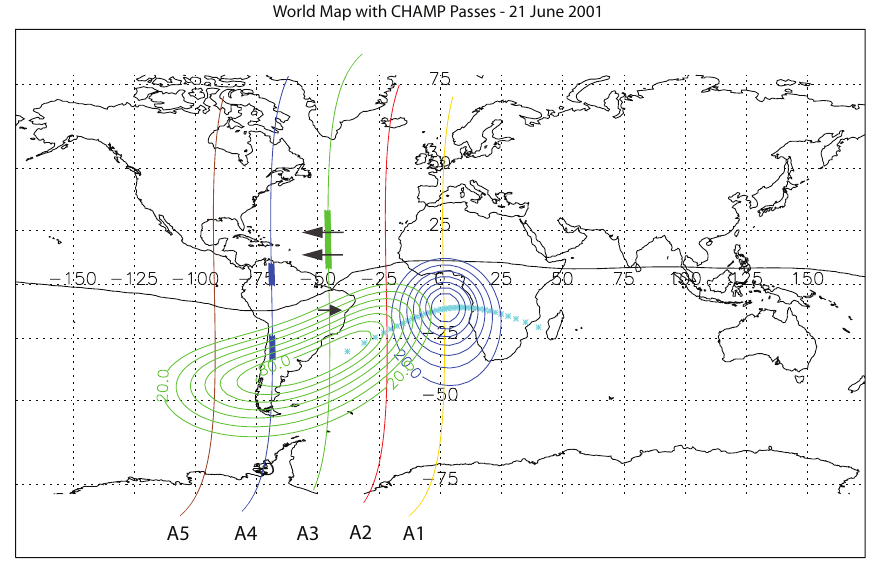
Fig. 10. World map projection for the 21 June 2001 eclipse, showing the path of the eclipse (cyan), the CHAMP passes considered and the latitude of the magnetic equator (solid line). The bold parts of pass A4 indicate the location of the FAC regions. Contours indicate the expected shadow distribution at the time of the dip equator crossings of passes A3 and A4 (green and blue,